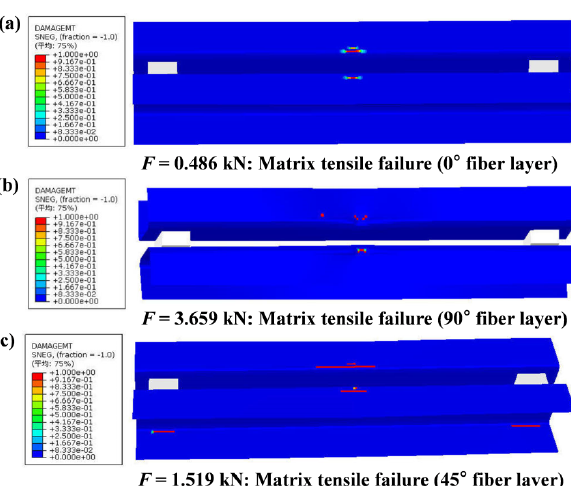
Figure 17: Initial matrix tensile failure area distribution of fiber layers of double-channel CARALL beam: (a) SHCXL-A: 0 ∘ fiber layer; (b) SHCXL-A: 90 ∘ fiber layer; and (c) SHCXL-B: 45 ∘ fiber layer.